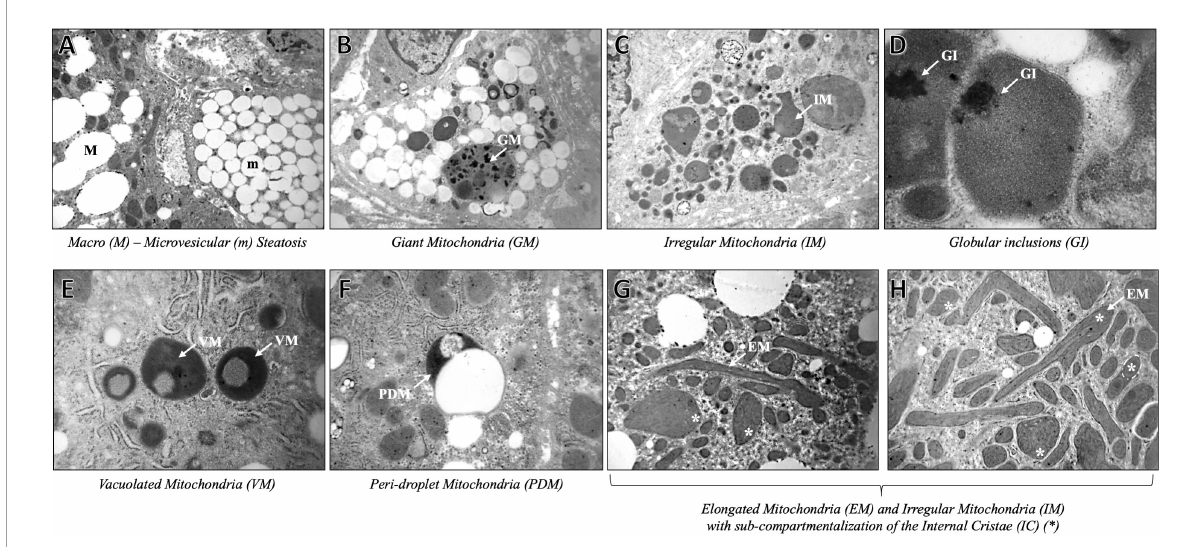
FIGURE1 Representative TEM images of mitochondrial ultrastructure aberrancies in a 40-year-old patient with non-alcoholic fatty liver disease, obtained by ultrathin 70-nm sections of hepatic biopsy. White arrows indicate the anomalies identified as follows: Macro (M) – microvesicular (m) steatosis (A) (3,000 × magnification), Giant Mitochondria (GM) (B) (4,400 × ); Irregular Mitochondria (IM) (C) (3,000 × ); Globular Inclusions (GI) (D) (20,000 × ); Vacuolated Mitochondria (VM) (E) (7,000 × ); Peri-droplet Mitochondria (PDM) (F) (7,000 × ); Elongated Mitochondria (EM), and IM with high-packed cristae and dense matrix, partitioned by the abnormal Internal Cristae (IC) (*) arrangement (G) (3,000X), (H) (4,440 × ).